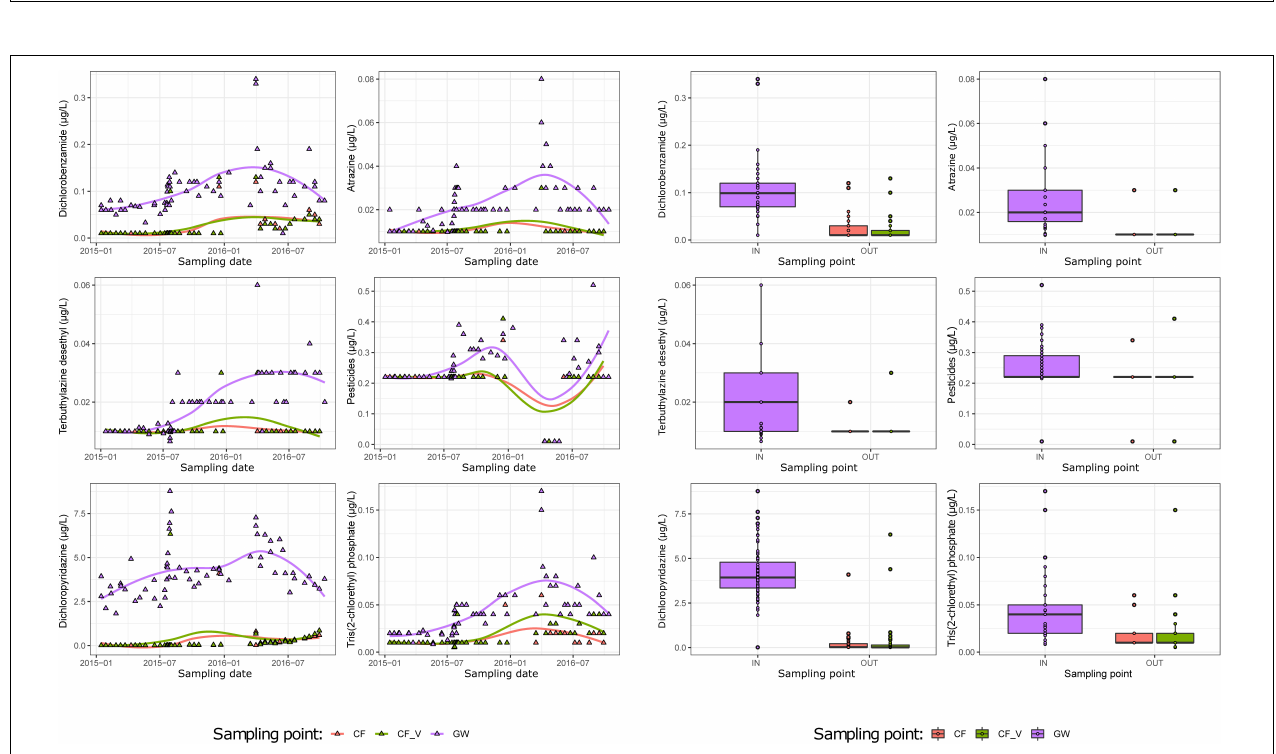
FIGURE 3 | Main pesticides and herbicides (dichlorobenzamide, atrazine, terbuthylazine desethyl, total pesticides, 3,6-dichloropyridazine, tris(2-chlorethyl) phosphate) measured in GW, CF and CF_V samples, showed per sampling date (left panel) and per sampling point (right panel).